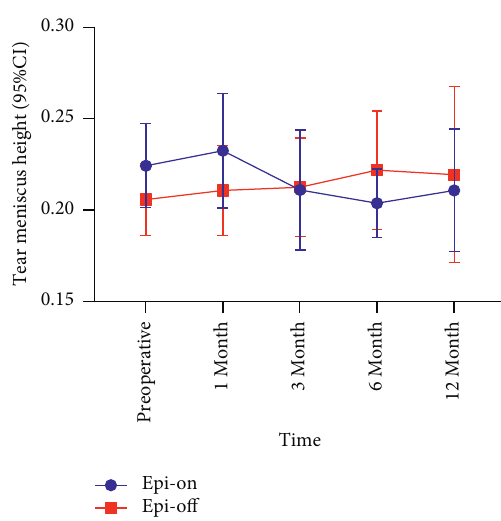
Figure 4: Comparison of the tear meniscus height during the 12- month follow-up period. CI: confidence interval.